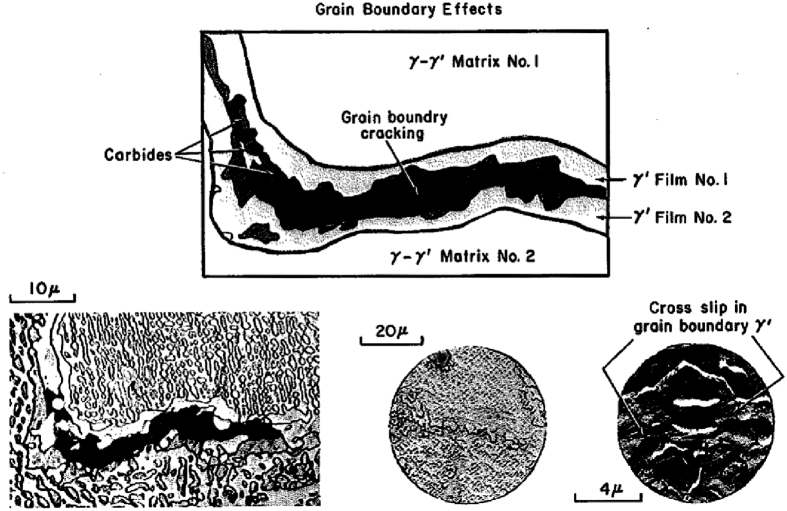
Flows and fracture behavior in the grain boundary of Waspaloy [20].